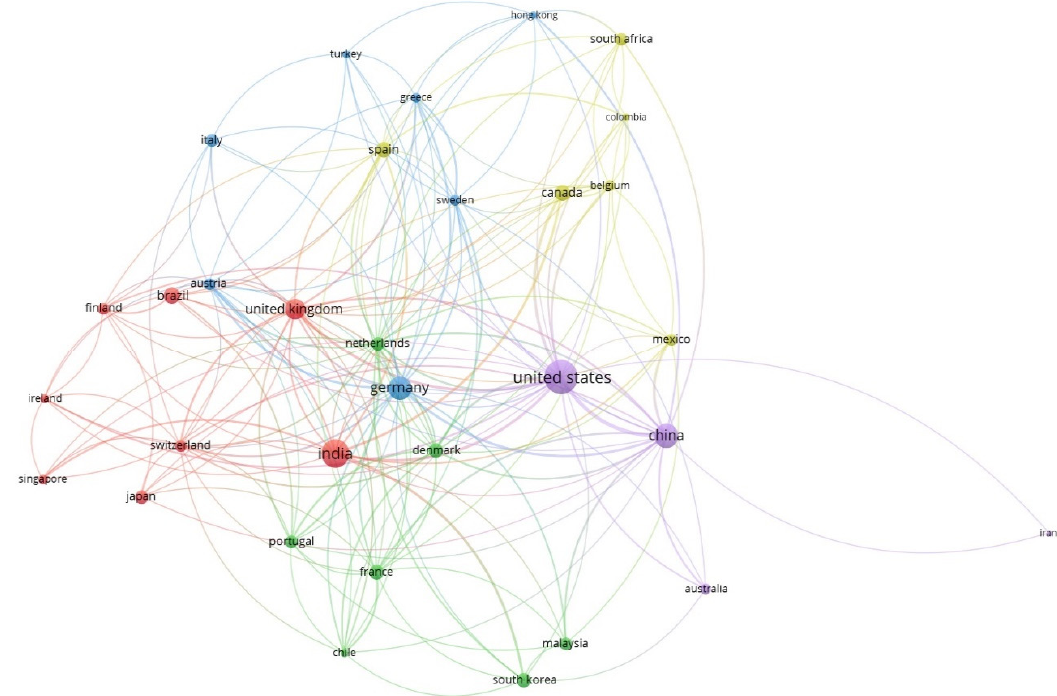
Figure 6. Co-authorship analysis: country-full counting. Source: elaborated by the authors based on Scopus [55].